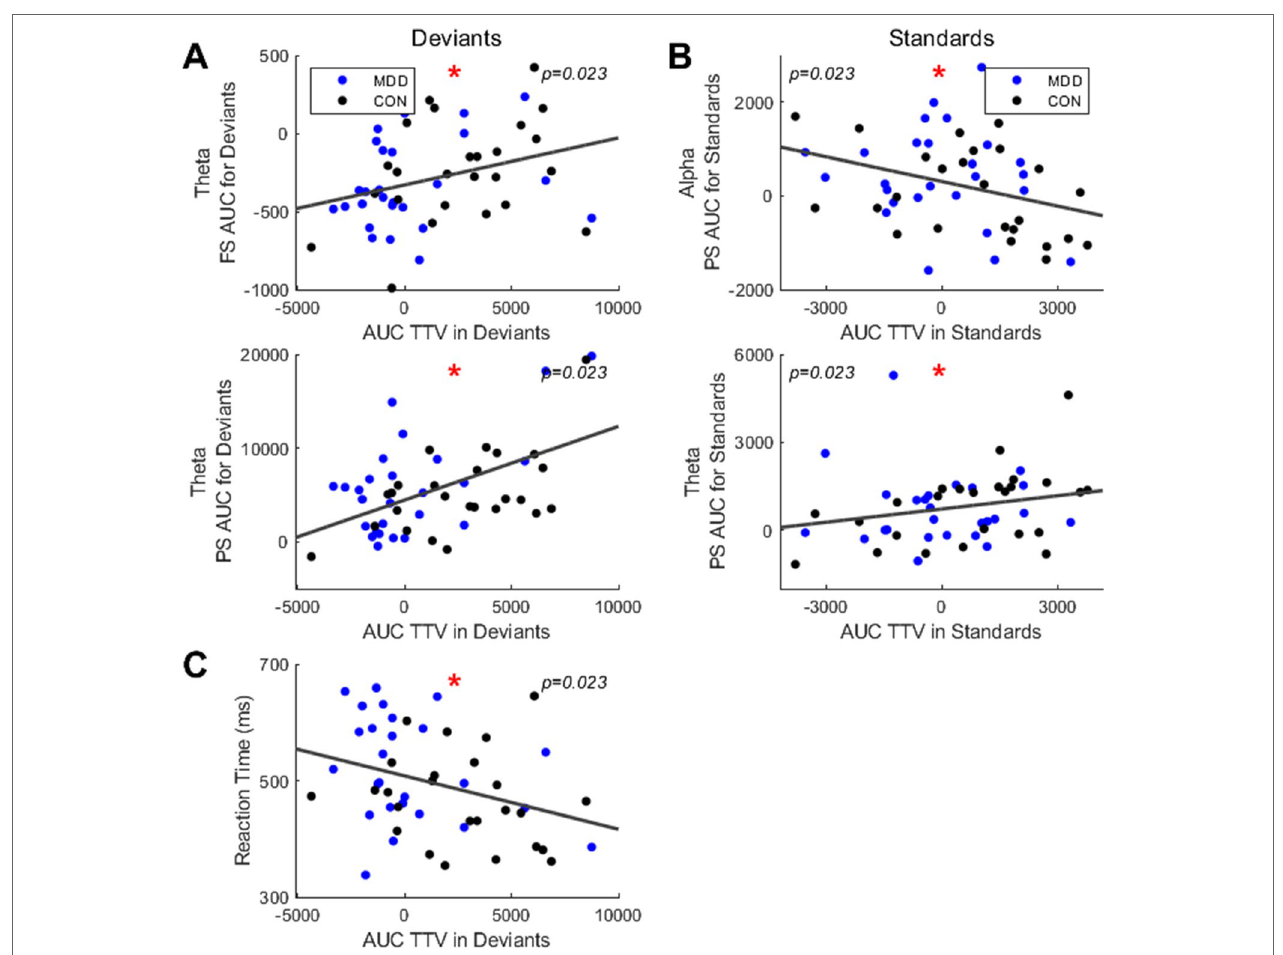
FIGURE 5 | Spearman correlations found significant relationships between area under the curve (AUC) in TTV and FS, PS and reaction times. (A) For deviant stimuli, AUC in TTV had significant correlations across all participants with FS and PS in the theta band. (B) For standard stimuli, AUC in TTV had significant correlations with PS in theta and alpha. (C) AUC in TTV for deviant stimuli correlated significantly with the mean reaction time. All p -values are FDR corrected for multiple comparisons. *: <